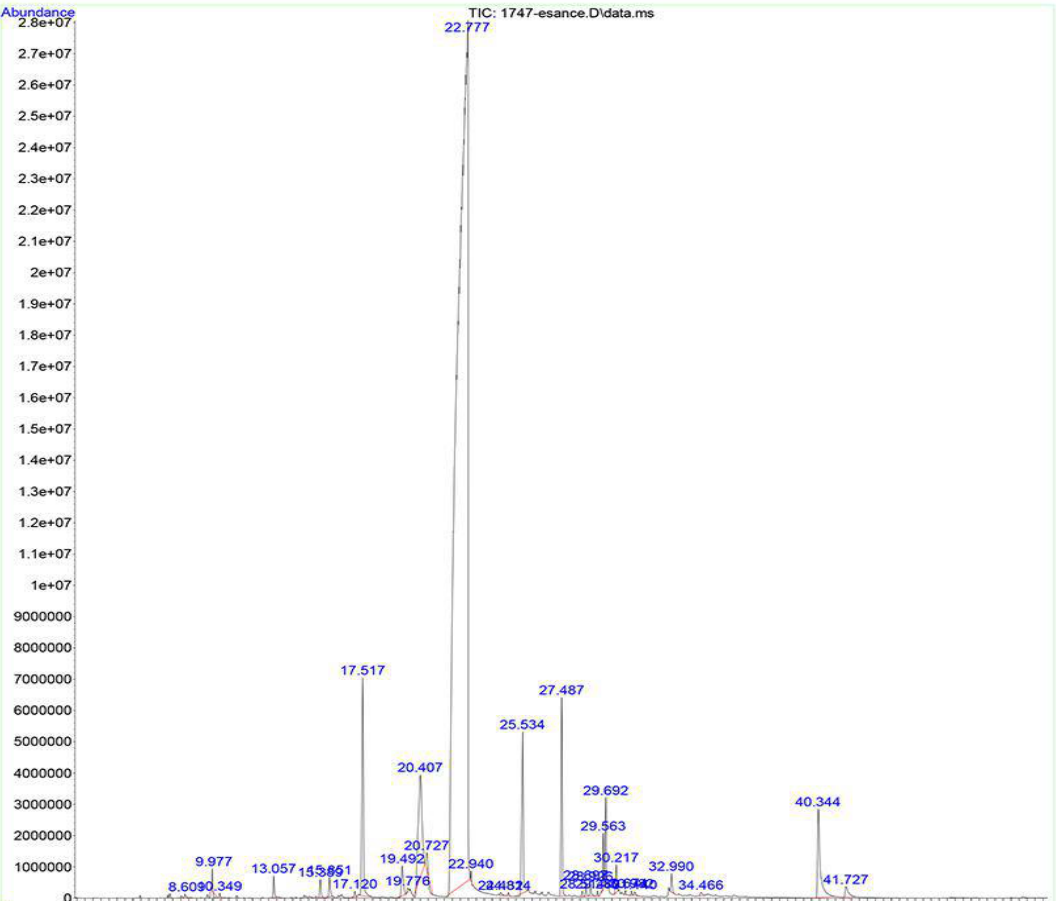
Figure 1. A typical total ion chromatogram (TIC) of Pimpinella anisum essential oil.